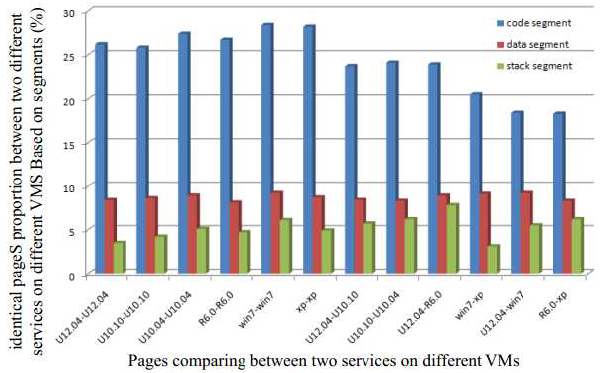
Figure 1. Proportion of identical pages for two different services running on different Virtual Machines for the different segments (code segment, data segment, and stack